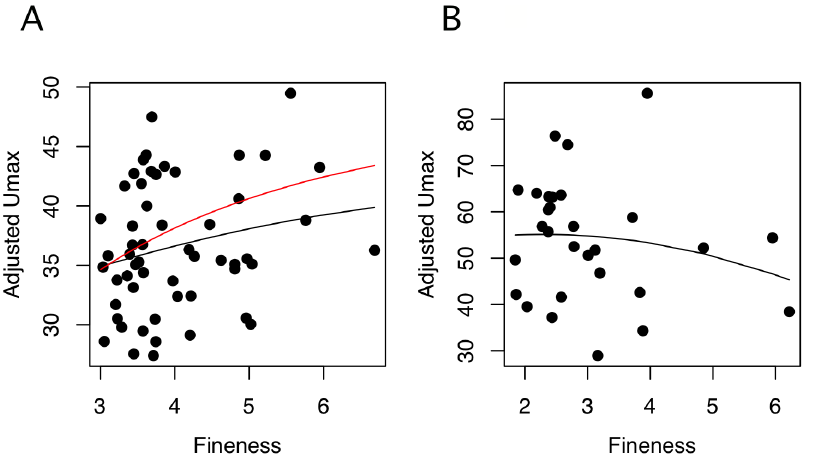
Figure 3. Maximum prolonged-swimming speed as a function of fineness in coral reef fishes. (A) pectoral-fin (MPF) and (B) body and caudal fin (BCF) subsets. The values are adjusted using the residuals from the regression of U max on M 1/3 and AR (fin aspect ratio). The red line is the modeled U max (eq. 2). The black lines are the quadratic fit of the adjusted U max on fineness ( f ).